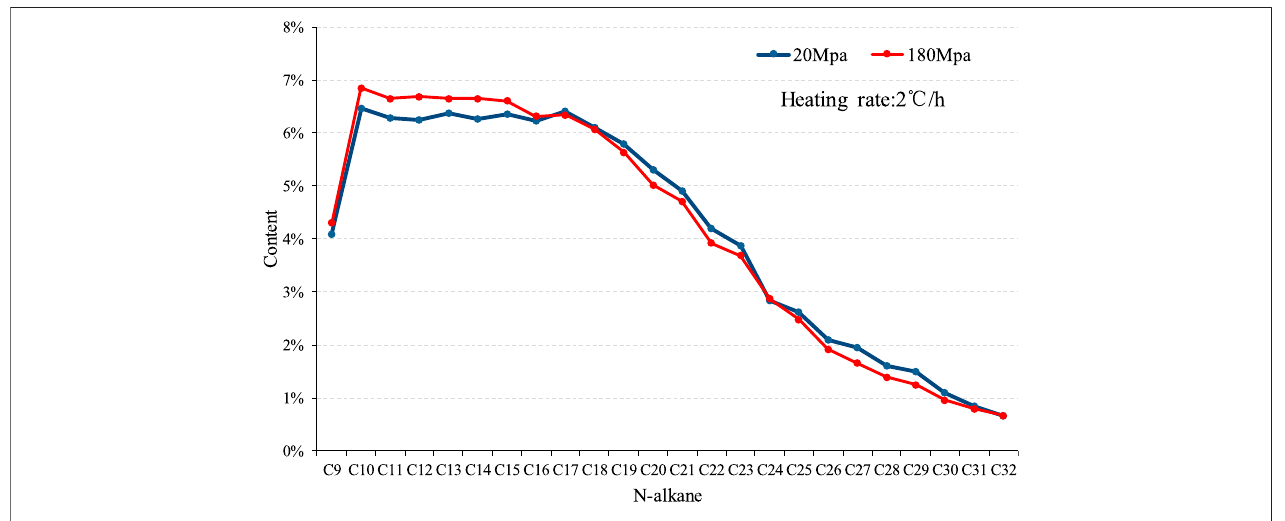
FIGURE 11 | Composition comparison of liquid hydrocarbon products of sample 2,911 under different pressure conditions at the same heating rate.